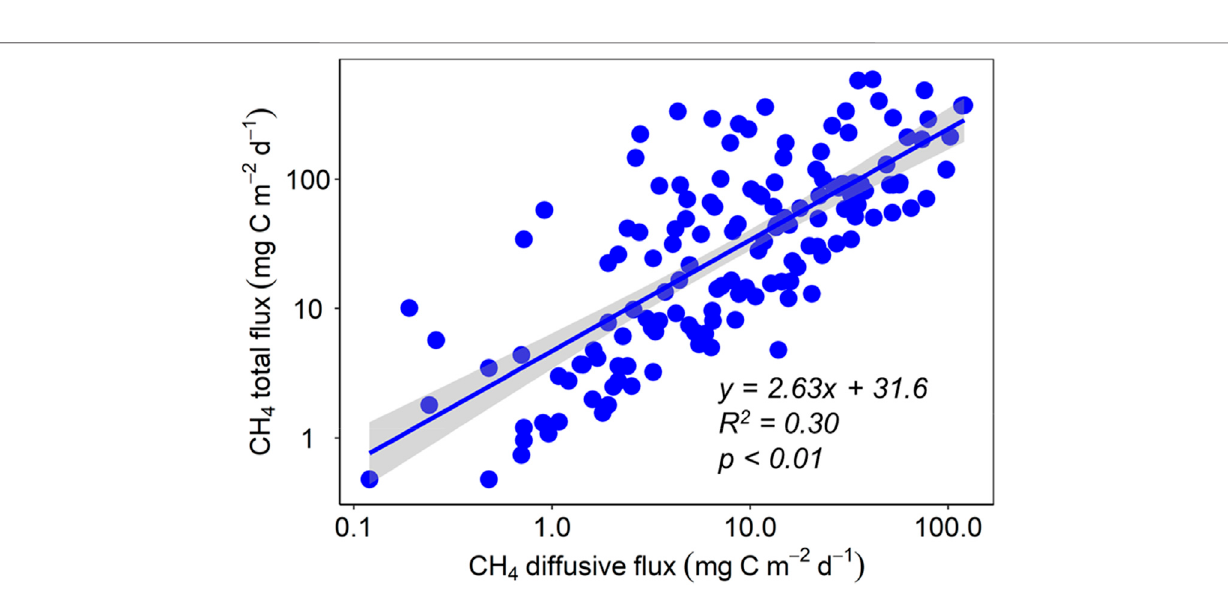
Frontiers in Environmental Science |